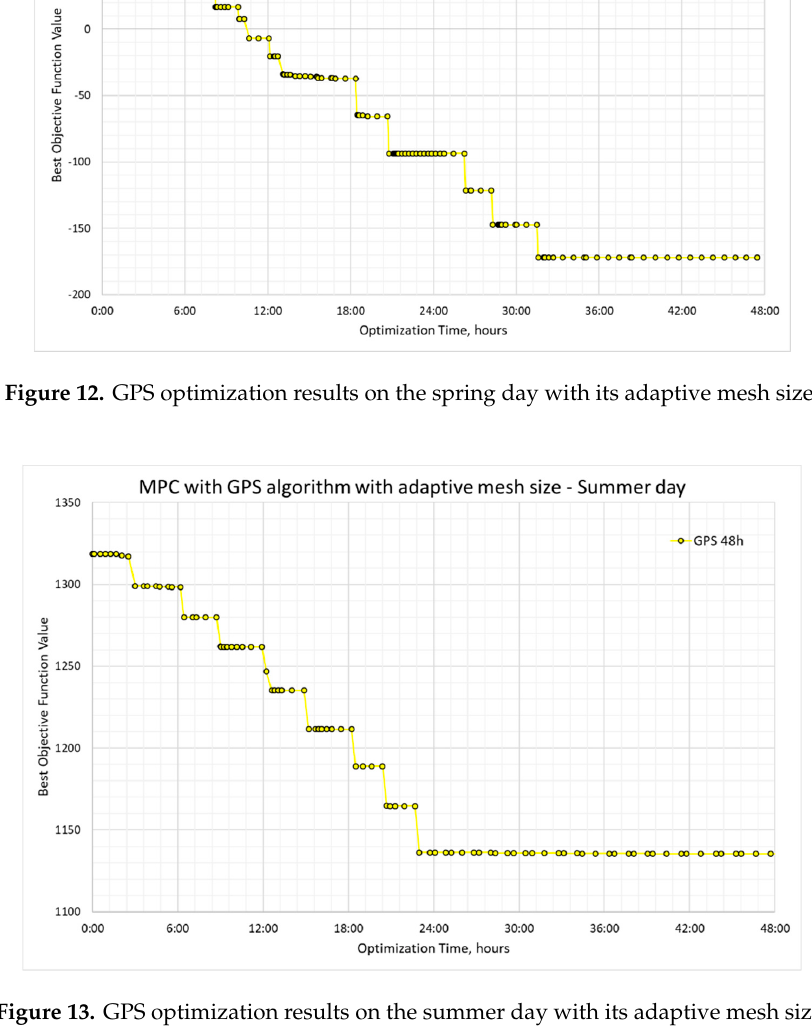
Figure 12. GPS optimization results on the spring day with its adaptive mesh size.